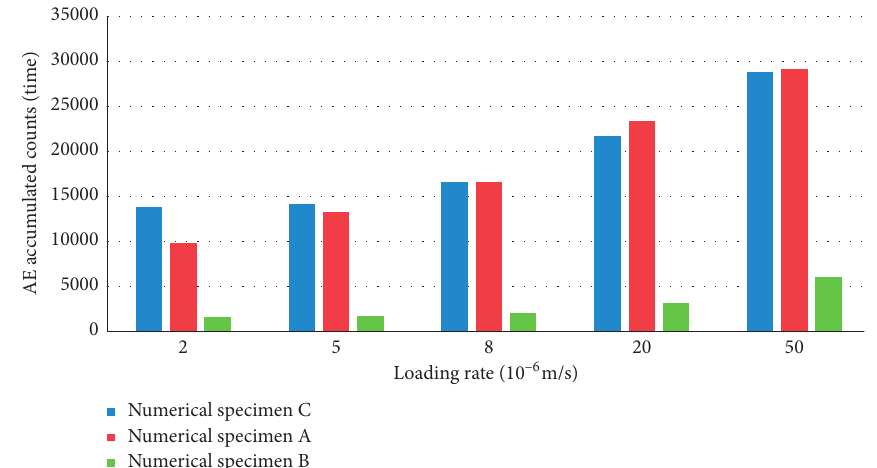
Figure 13: Longitudinal contrast of AE accumulated counts of three kinds of numerical